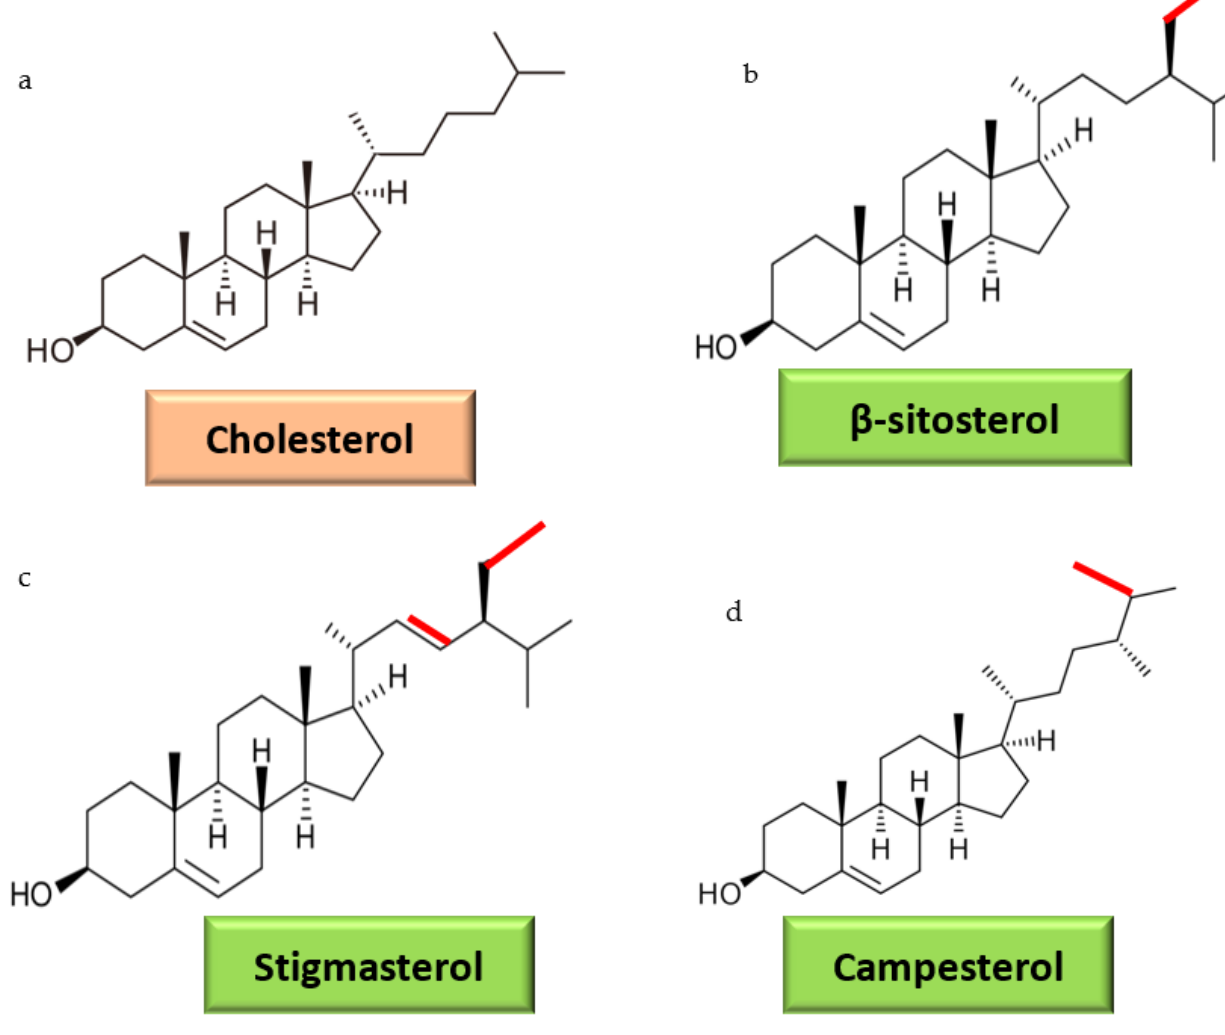
Figure 1. ( a ) Structure of cholesterol, ( b ) structure of β -sitosterol (ethyl group represents in red line), ( c ) structure of stigmasterol (ethyl group and double bond represented by red line), and ( d ) structure of campesterol (methyl group represented by red line). Table 1. Studies on biological activity of phytosterol from plants or as